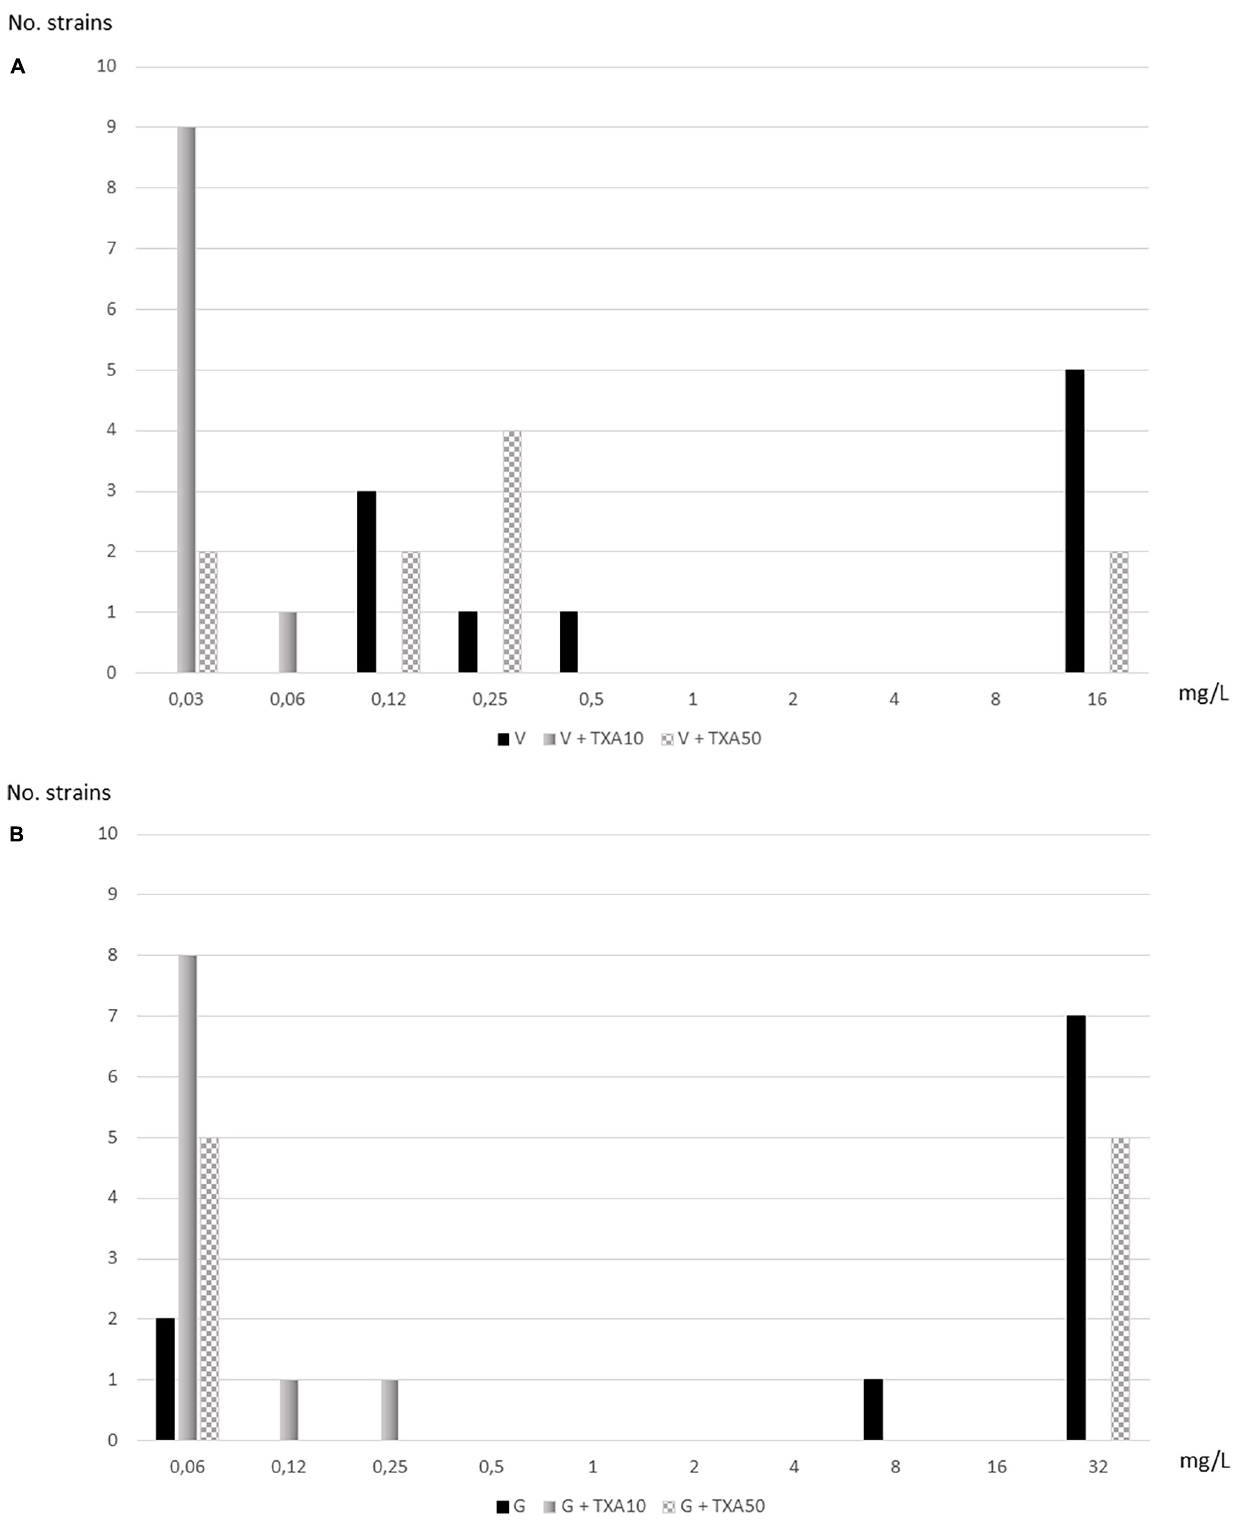
Frontiers in Microbiology |